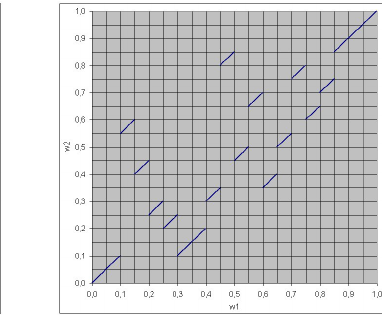
Figure 19: UF copula driver,